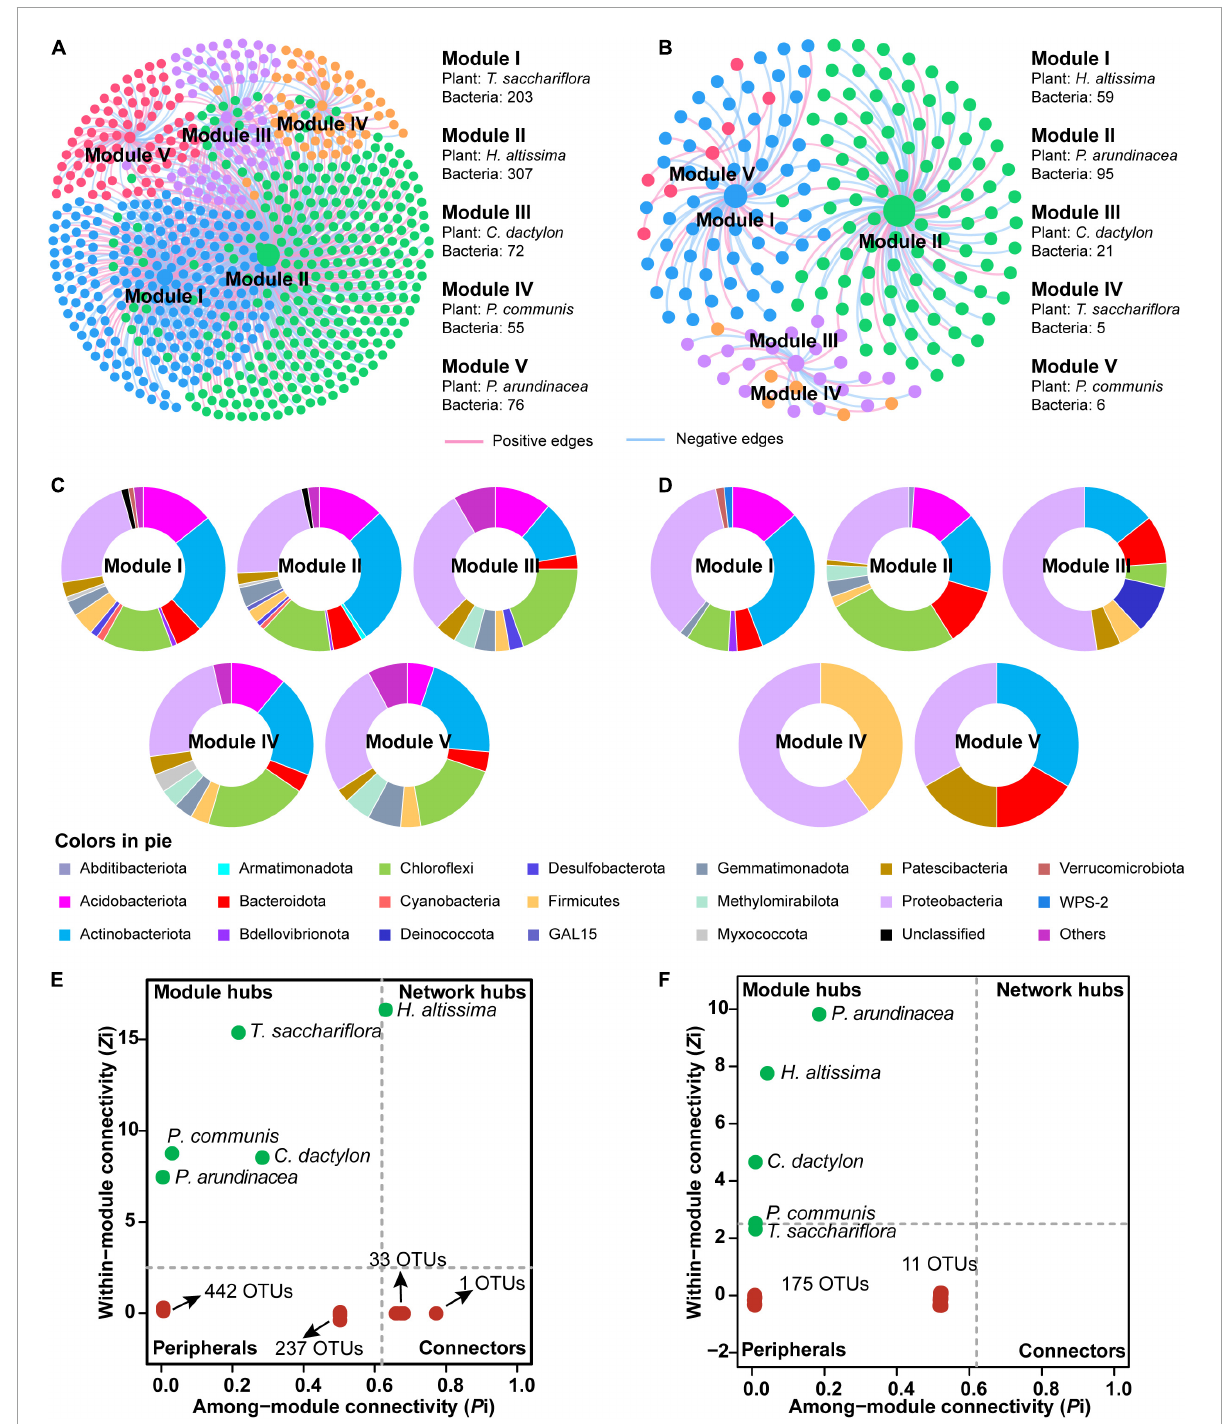
FIGURE6 Module separation results (A,B) , brief summary of plant species and bacterial phyla within each module (C,D) , and the modular roles of plant species and bacteria based on Zi - Pi plot for the observed interdomain ecological network (IDEN) (E,F) between plants and bulk and rhizospheric soils, repsectively. For each module, the number of connected bacterial nodes to each plant is shown. The pie charts show the composition of bacterial operational taxonomic units (OTUs) on phylum level within corresponding modules. The relative abundances of top four phyla in each pie chart are